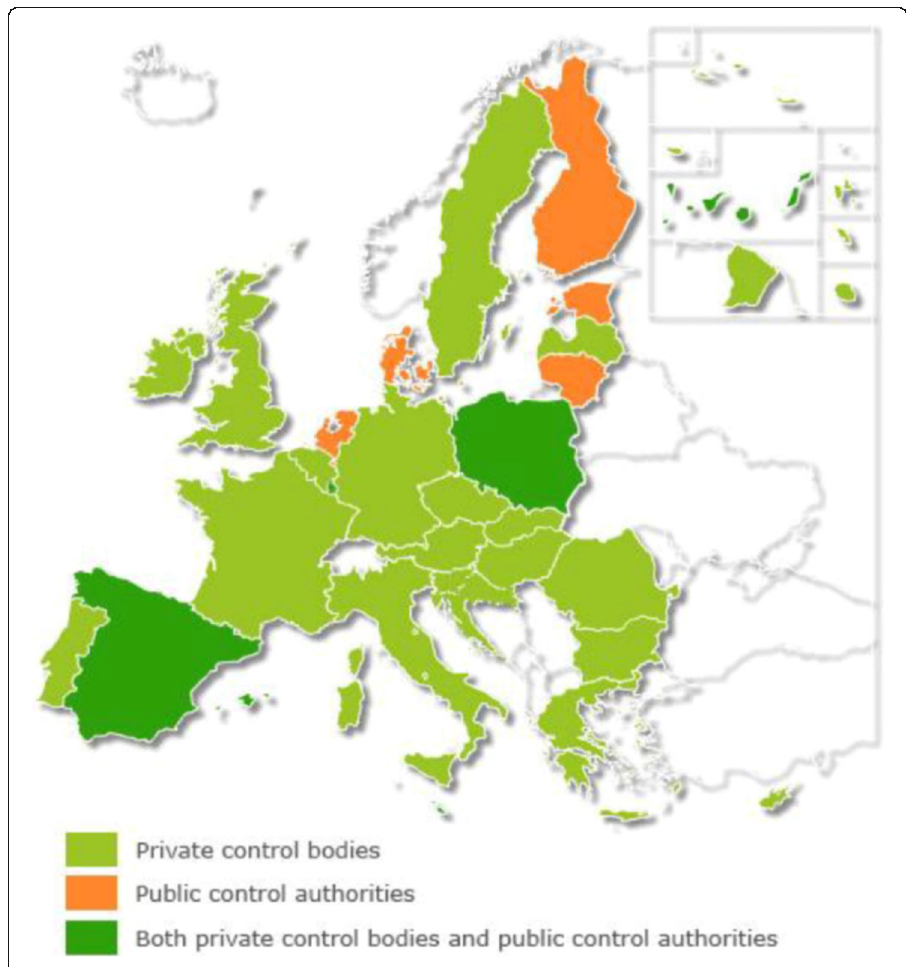
Fig. 1 The organization of the EU control system for organic food products. Source: INEA,